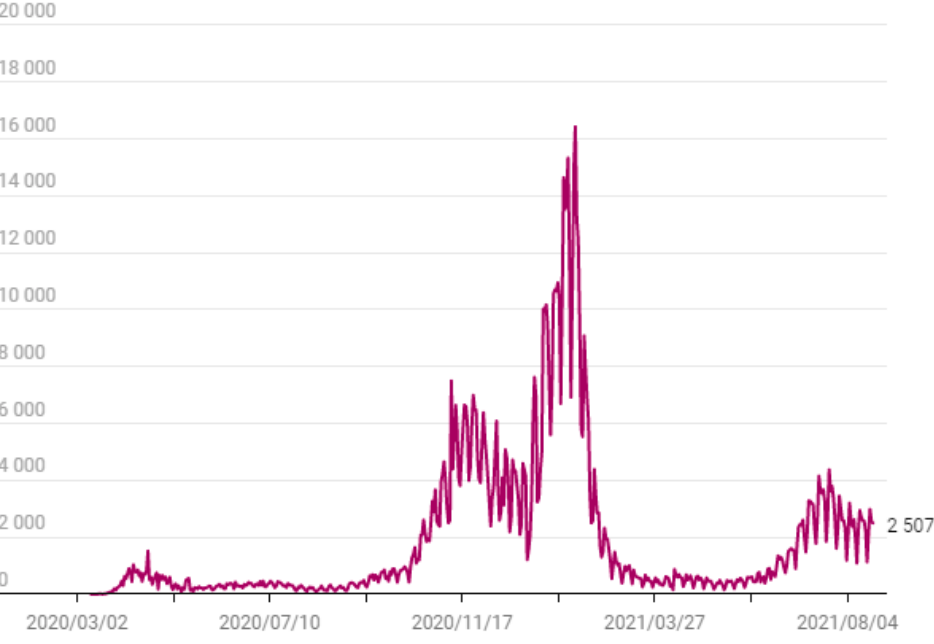
Figure 1. Evolution of new cases per day in Portugal. Source: https://expresso.pt/coronavirus/20-0-2021-Covid-19, accessed on 16 May 2020.